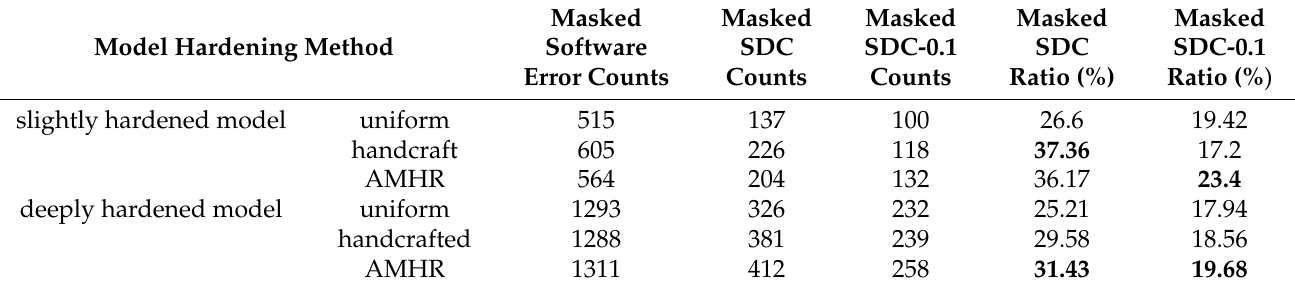
Table 2. Detailed information of masked errors.